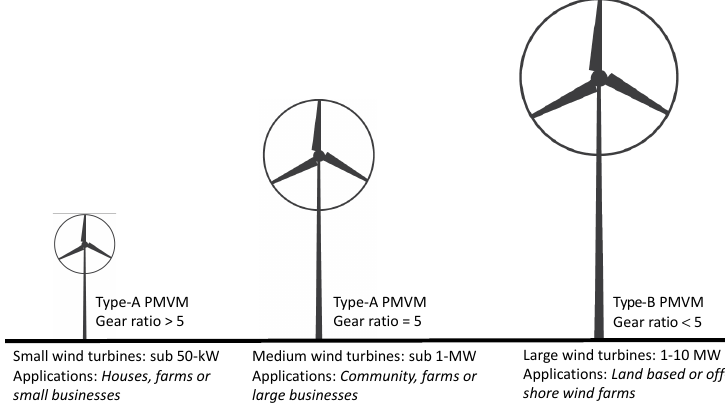
Figure 21. Recommended PMVM gear ratios for different wind power